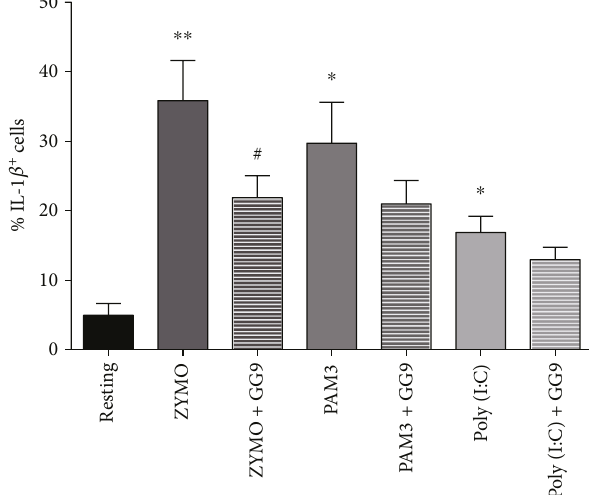
Figure 7: E ff ect ofGG9on macrophage cell-boundIL-1 β expression induced by TLR ligands. After di ff erentiation, macrophages were pretreated with GG9 for 30 min, and then incubated with zymosan (10 μ g/ml), Pam3CSK4 (PAM3, 0.3 μ g/ml), and Poly(I:C) (50 μ g/ml) for 24h at 37 ° C in RPMI +10% FBS in the presence of brefeldin (10 μ M) over the last 4h to disrupt cytokine secretion pathways. Prior to fl ow cytometry analysis, fi xed/permeabilized cells were stained with anti-IL-1 β antibody. Bar graphs represent the mean ( ± SEM) of 4 independent experiments. ∗ p < 0 05 ; ∗∗ p < 0 001 versus resting; and # p < 0 05 versus TLR